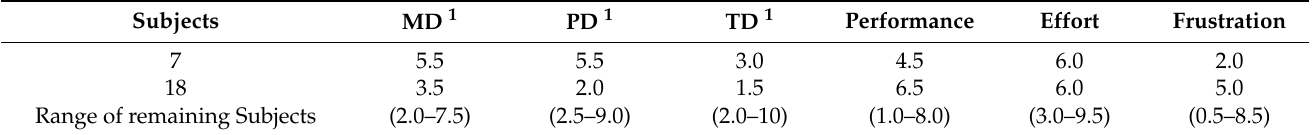
Table 2. Nasa-TLX scores for NP task in Session